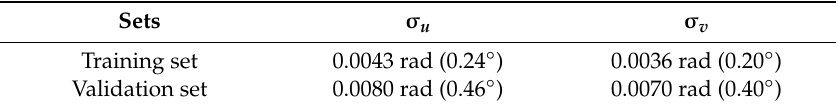
Table 1. Errors of coordinates u and v (for correspondent angles φ u and φ v ) for the object origin projection location.